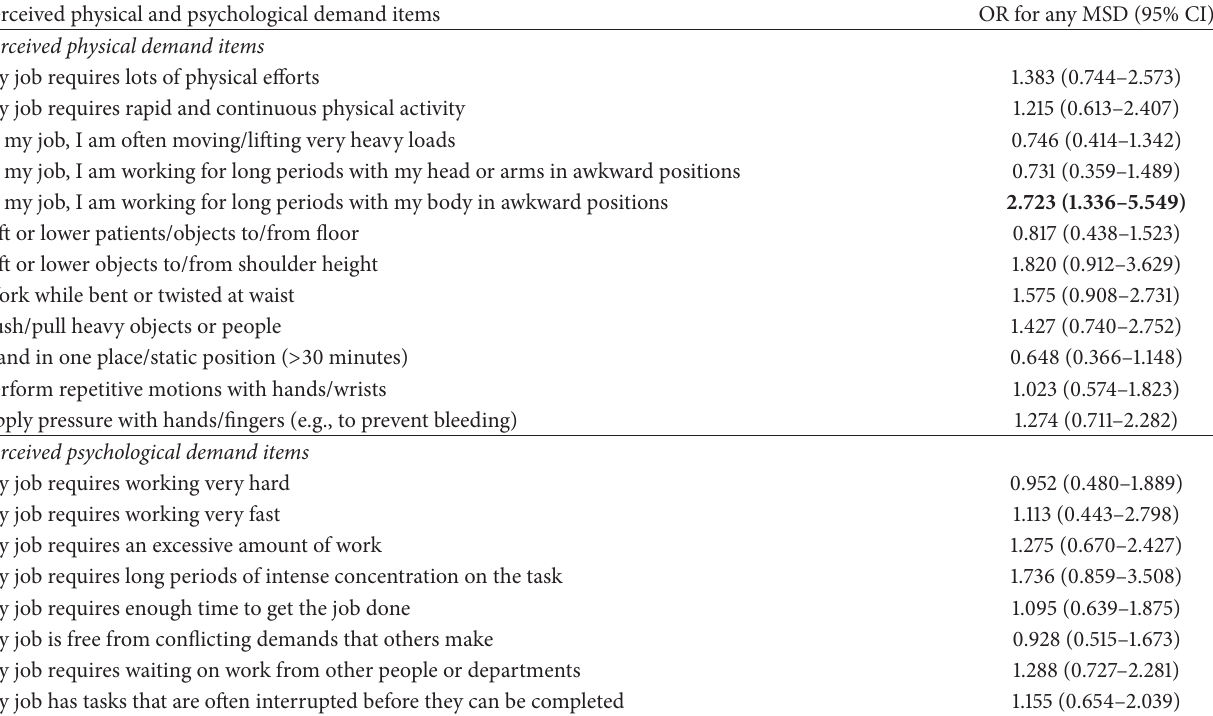
Table 4: Association of occurrence of any MSD with perceived physical and psychological demands at work, Multiple Logistic Regression analysis.